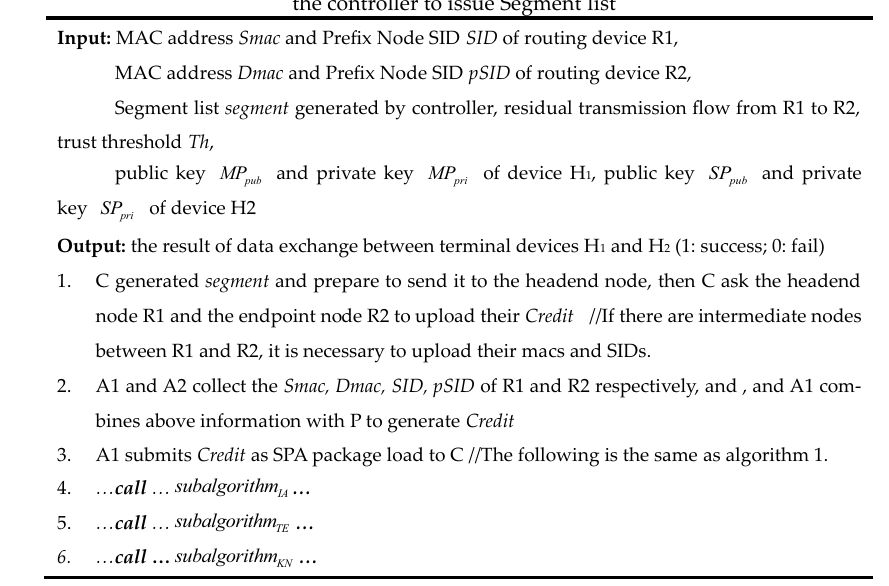
Algorithm2 data exchange security algorithm in the mode for